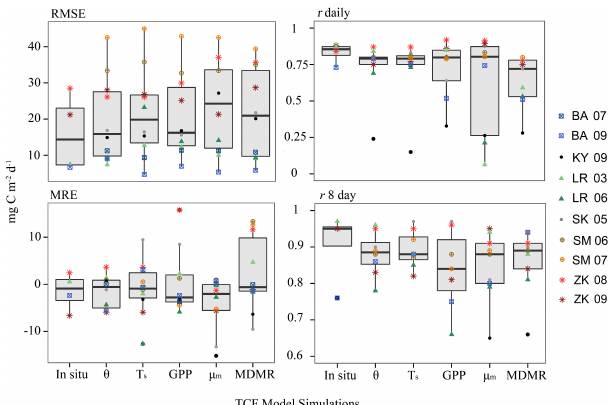
Fig. 7. TCF model accuracy relative to CH 4 records from six tower EC sites. Model simulations include those derived from in situ mea- surements; reanalysis soil moisture ( θ) , soil temperature ( T s ), sur- face wind velocity ( µ m ) or TCF LUE model simulated GPP inputs; TCF simulations derived solely from remote sensing and reanalysis (MDMR) inputs. Measures of comparison include RMSE, MRE, r values for daily and 8day cumulative fluxes. Results for BA 2009 are means for north, central and southern Barrow tower